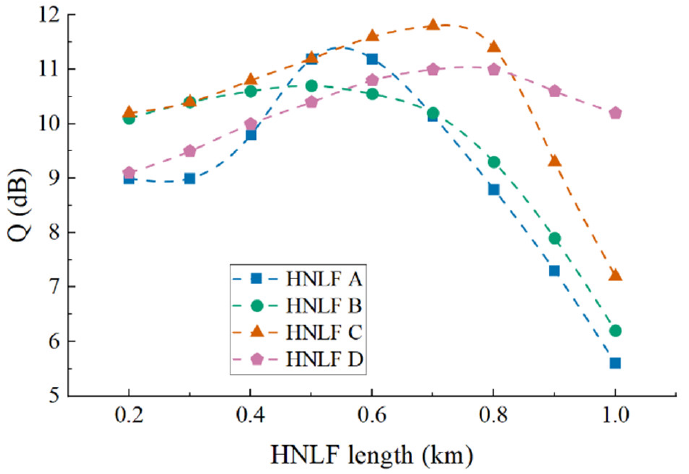
Figure 4. A comparison of Q-factor versus HNLFs length.